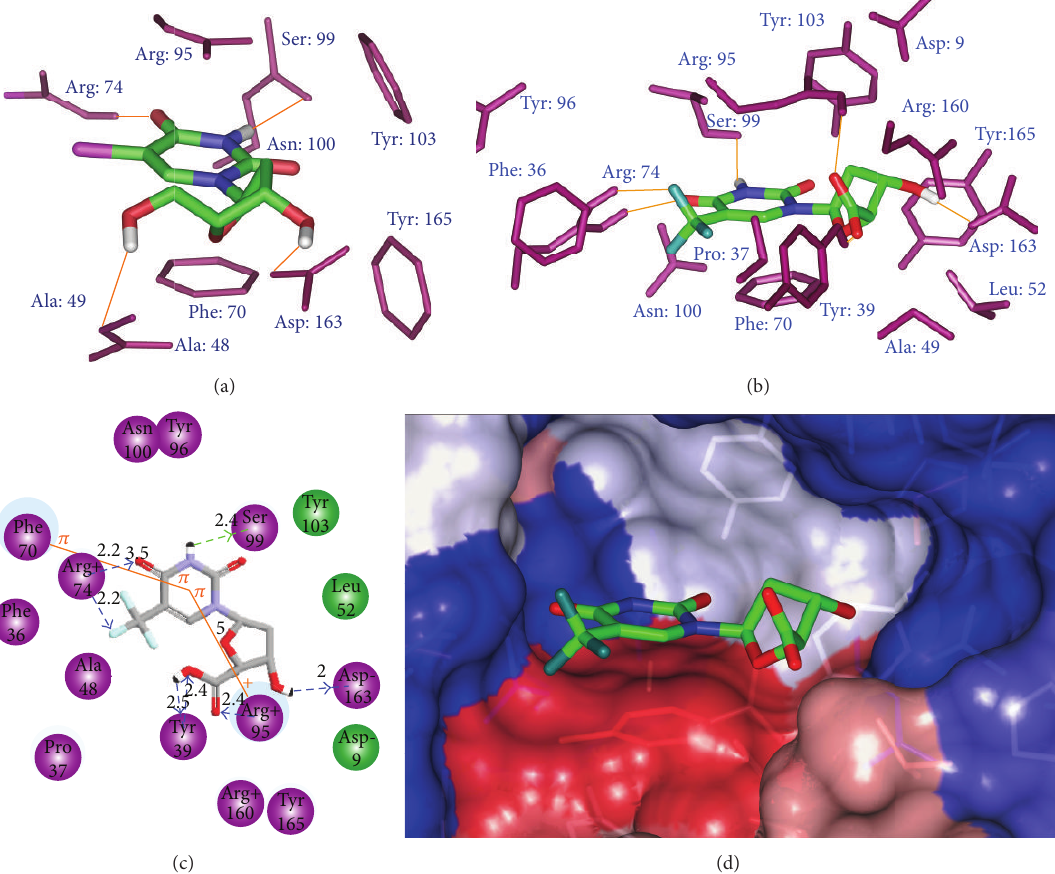
Figure 5: Close-up of TMD4 (a) and TMA12 (b) at the active site of TMPK mt . Hydrogen bonds are shown in orange color and the residues are in purple color. Interactions of inhibitor TMA12 at the active site in 2D depiction (c). Connolly surface of the same active site (d). The binding cleft surface is colored according to residue hydrophobicity: red-hydrophobic, blue-hydrophilic and white-intermediate residues.